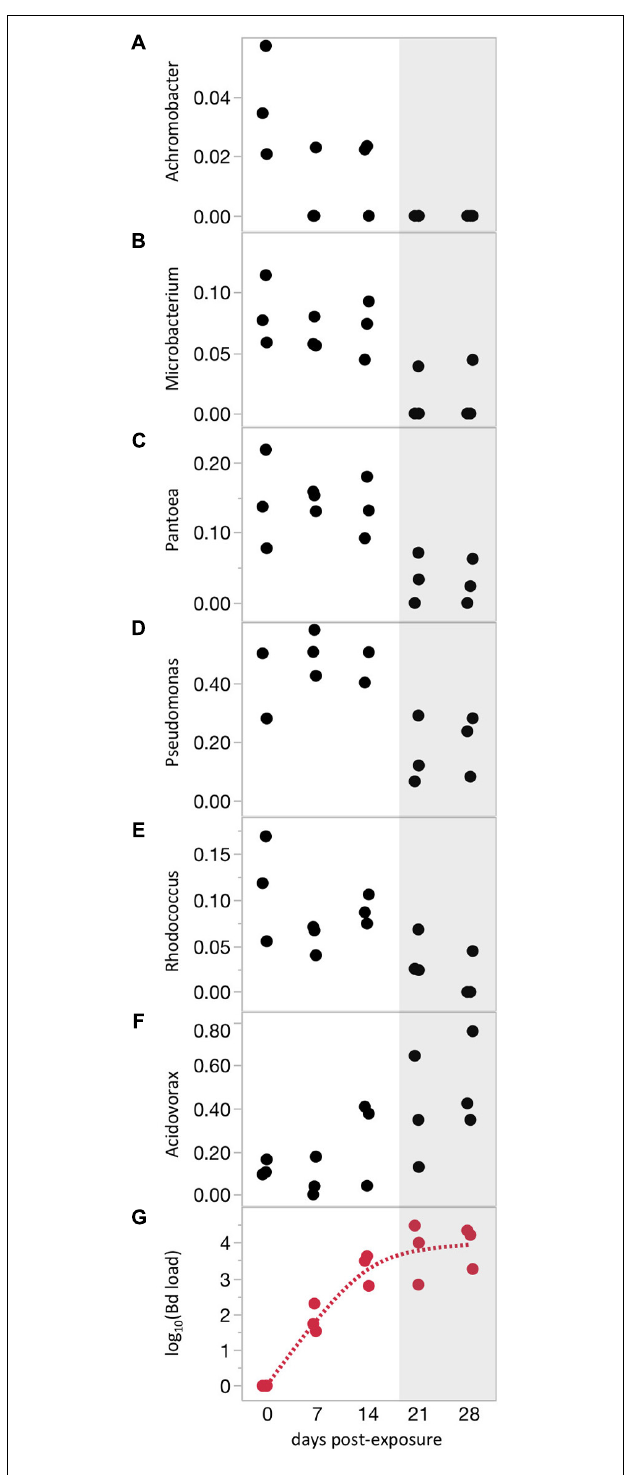
FIGURE 3 | Bacterial phylotypes shift with increasing Bd severity. (A–F) Relative abundances of phylotypes with significant correlations with time over the course of Bd infection. (G) Bd load trajectory. Shaded area highlights region of highest Bd loads. All correlations shown are statistically significant ( P < 0.05, Q < 0.05). Relative abundance data are arcsine(square root)